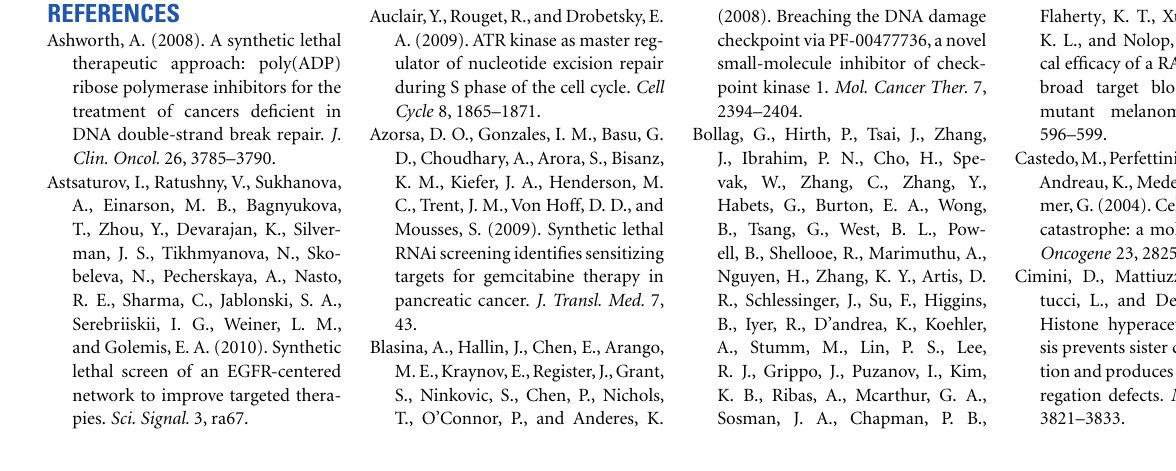
( Figure 4 ). Synthetic lethality is exemplified in BRCA2 mutant breast cancer cells where base excision repair (BER)